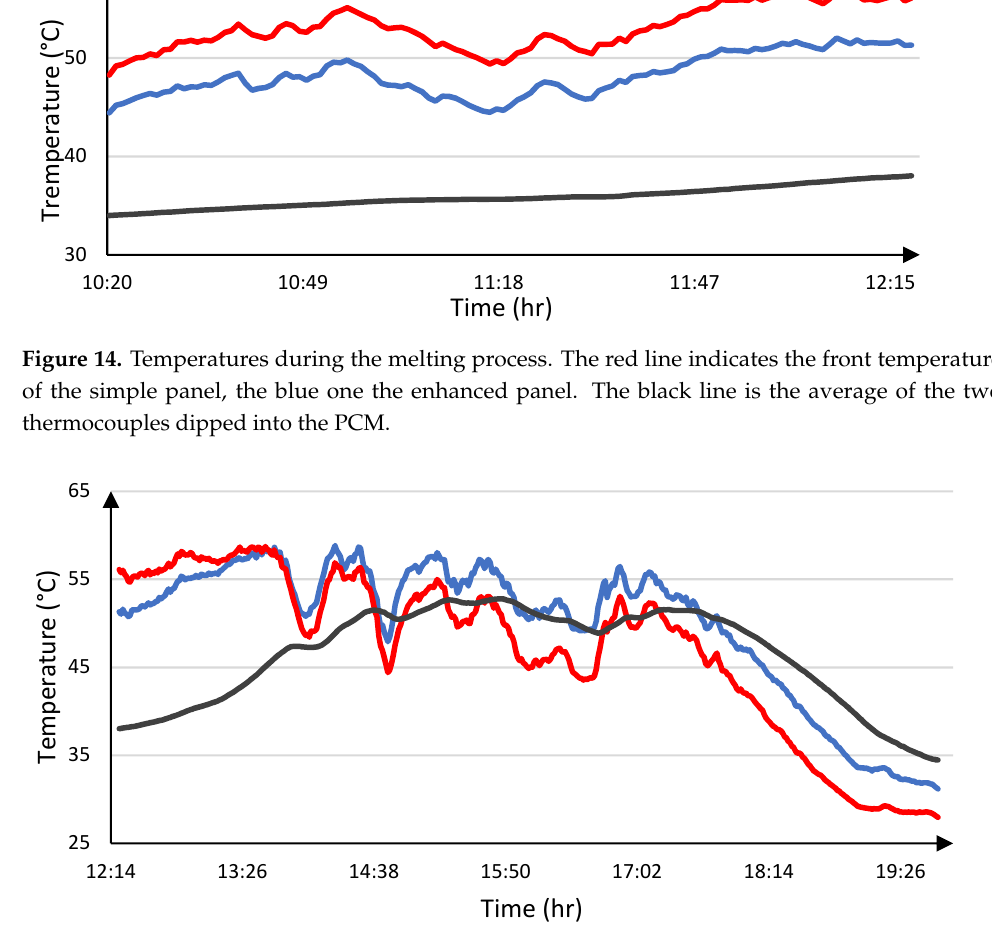
Figure 15. Temperatures during liquid state PCM. The red line indicates the front temperature of the simple panel, the blue one the enhanced panel. The black line is the average of the two thermocouples dipped into the PCM.